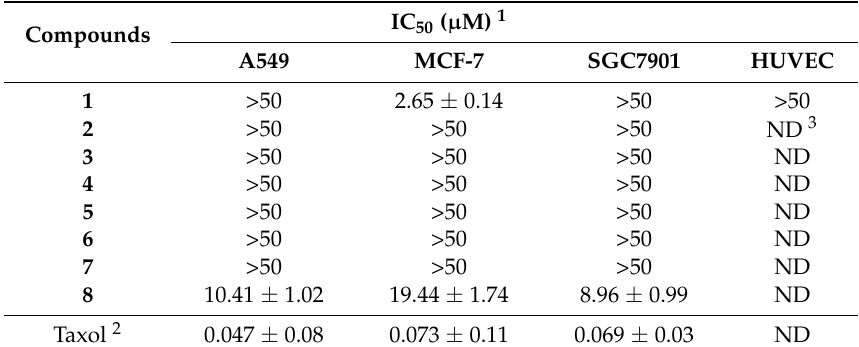
Table 2. Cytotoxicity of compounds 1 – 8 against A549, MCF-7, SGC7901 and human umbilical vein endothelial (HUVEC)